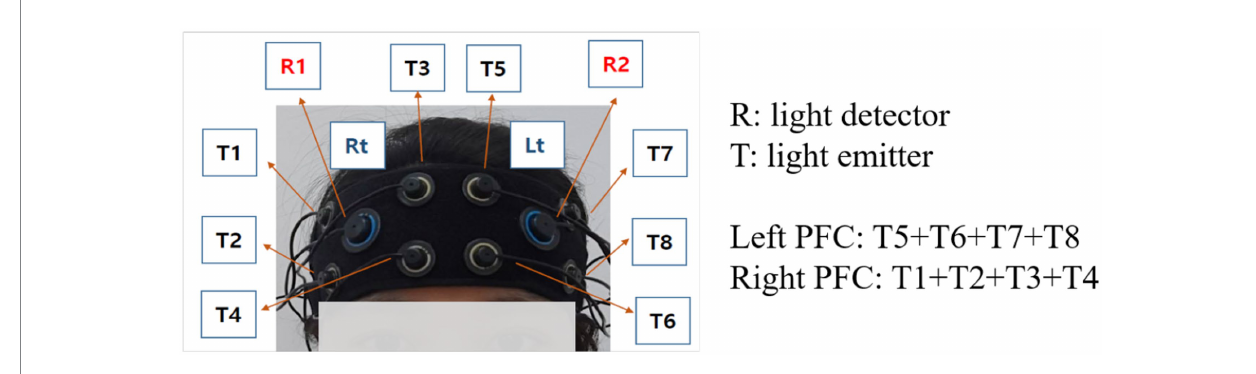
FIGURE 1 The montage of fNIRS channels.